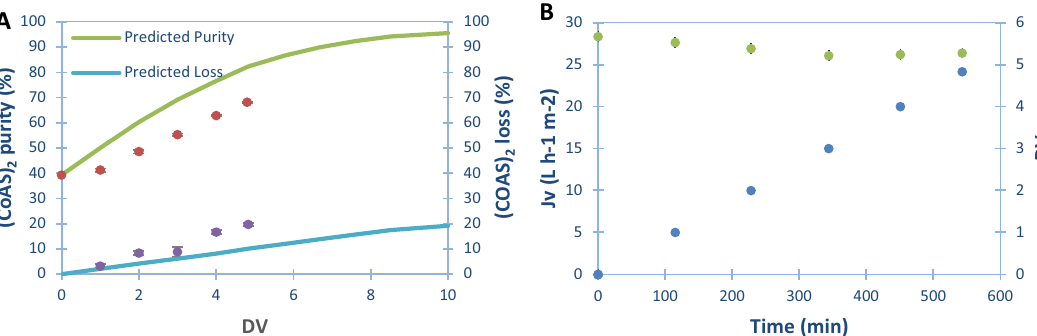
Figure 6. ( A ) Evolution of (CoAS) 2 purity ( ) and loss ( ) as a function of diafiltration volume (DV) during dia-ultrafiltration process with 5.19 g L −1 solution. ( B ) Evolution of permeate flux (Jv) ( ) and diafiltration volume (DV) ( ) as a function of time, with 5.19 g L −1